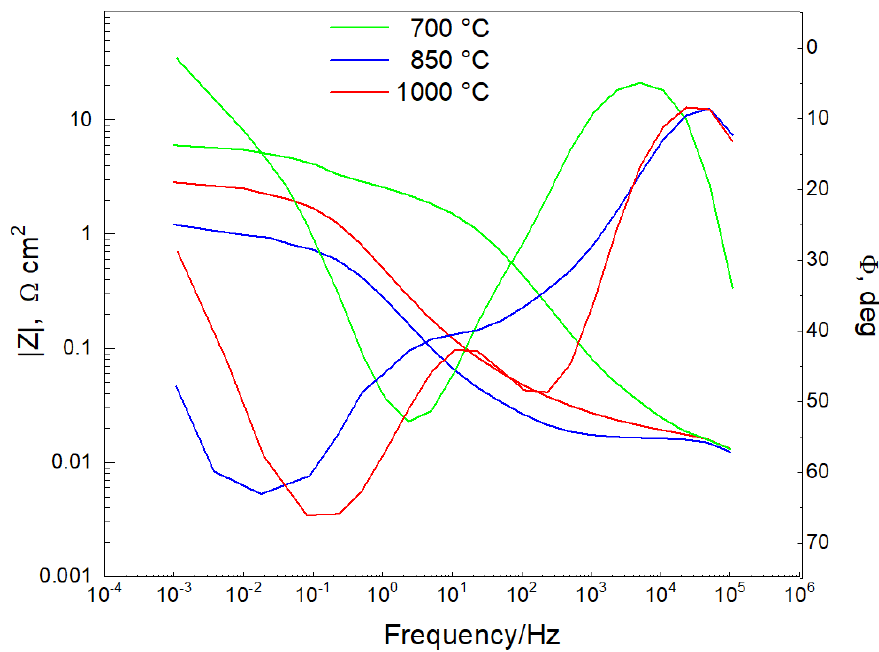
Figure 5. Bode diagram for the Bi 3.75 La 0.25 Ti 3 O 12 composite.